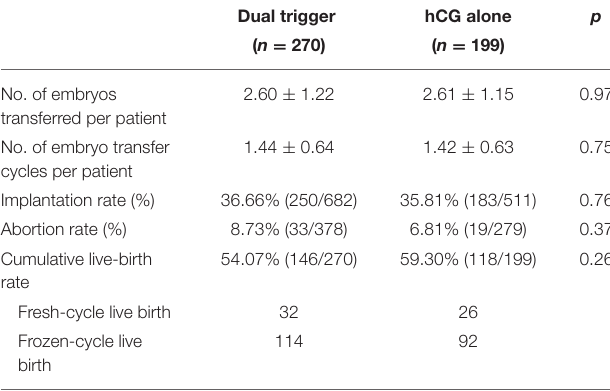
TABLE 2 | Comparison between the dual-trigger group and hCG-alone group: characteristics of ovarian stimulation.